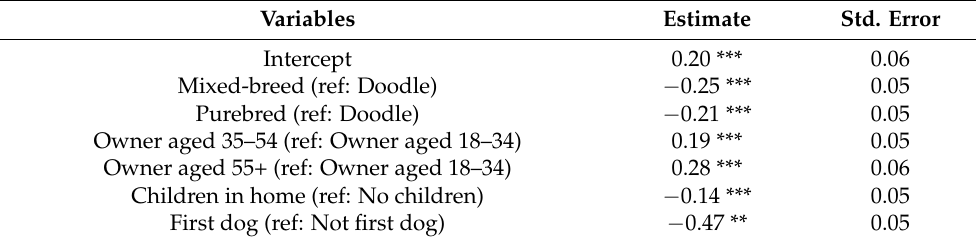
Table 6. The beta estimate and standard error for each factor in the general linear model examining the relationship between breed type, owner age, the presence of children in the home, whether this was the owner’s first dog, and owner